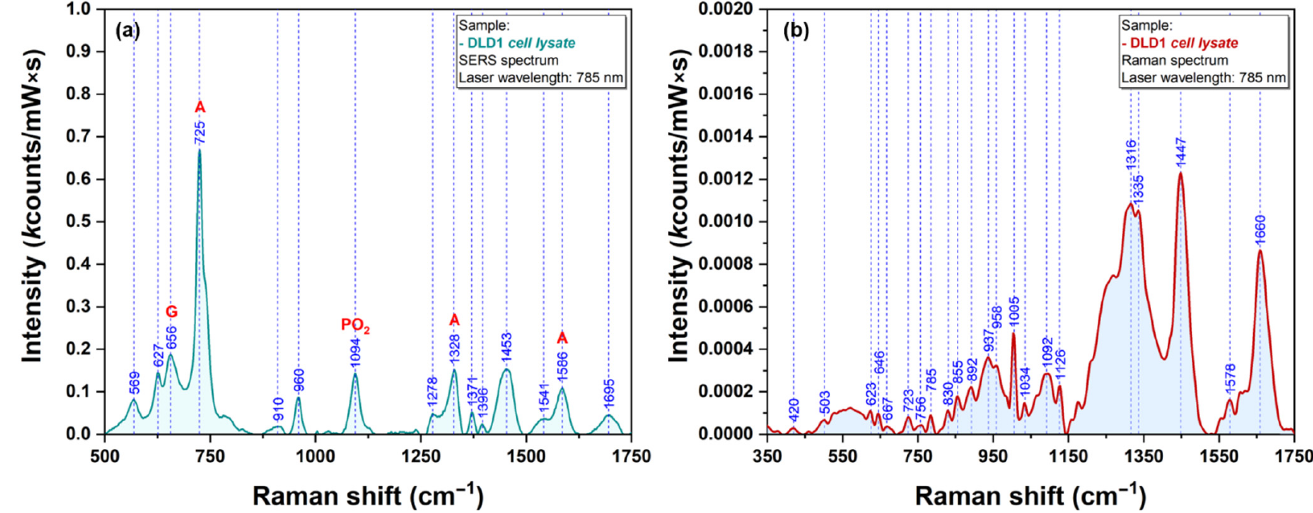
Figure 11. SERS spectra of DLD1 cell lysate obtained using a 785 nm excitation laser ( a ). Raman spectra of DLD1 cell lysate obtained using a 785 nm excitation laser ( b ).